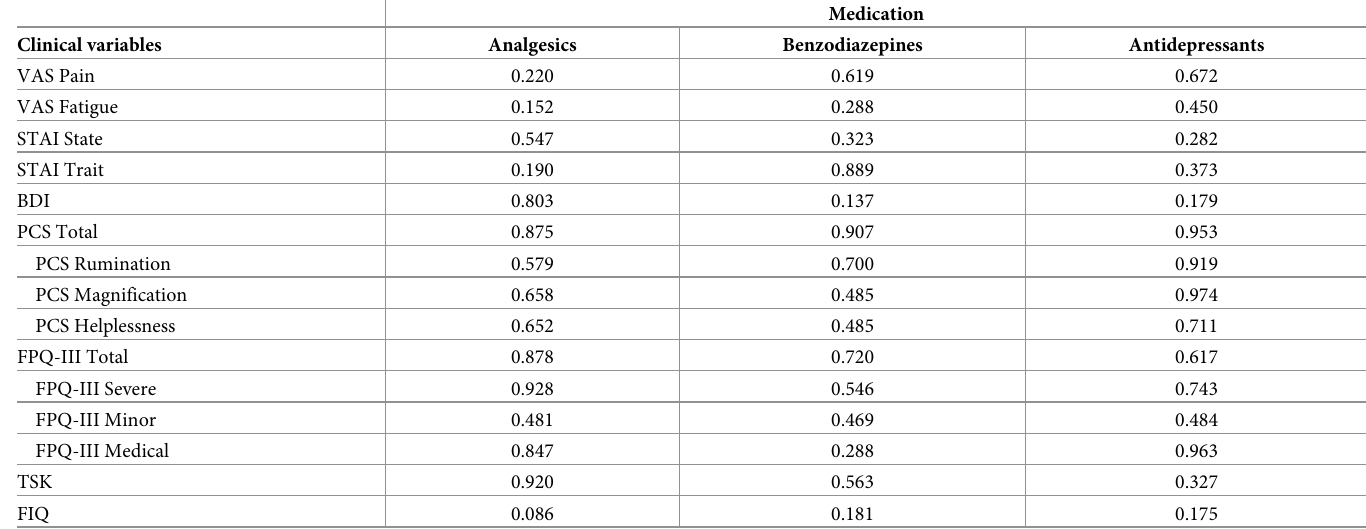
Table 5. P-values related to the medication effect (analgesics, benzodiazepines and antidepressants) on clinical measures (pain, fatigue, anxiety, depression, pain catastrophizing, impact of fibromyalgia, fear of pain and fear of movement) within the patients´